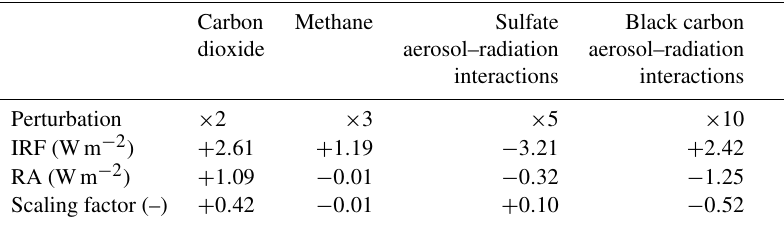
Table 9. Global, multi-annual mean top-of-atmosphere instantaneous radiative forcing (IRF), rapid adjustments (RA), and scaling factor for the rapid adjustments from PDRMIP models (Myhre et al., 2018).